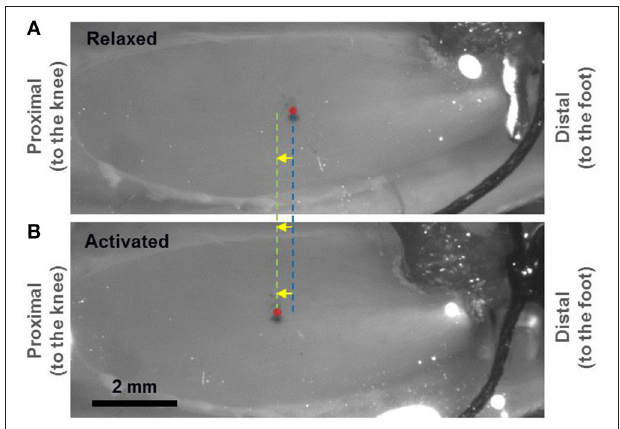
FIGURE 1 | Light micrograph showing a mouse tibialis anterior (TA) muscle prepared for second harmonic generation (SHG) imaging of in vivo sarcomeres. A small portion of the implanted tendon force transducer can be seen at the distal end. The mid-belly of the TA, marked by the red circle, displaced ∼ 375 µ m proximally when going from the relaxed (A) to the activated (B) state. Two fluorescent markers that were separated by 1mm were applied at the mid-belly of the TA (in proximity to the red circle) and observed under fluorescent light to measure the local displacement of the muscle caused by